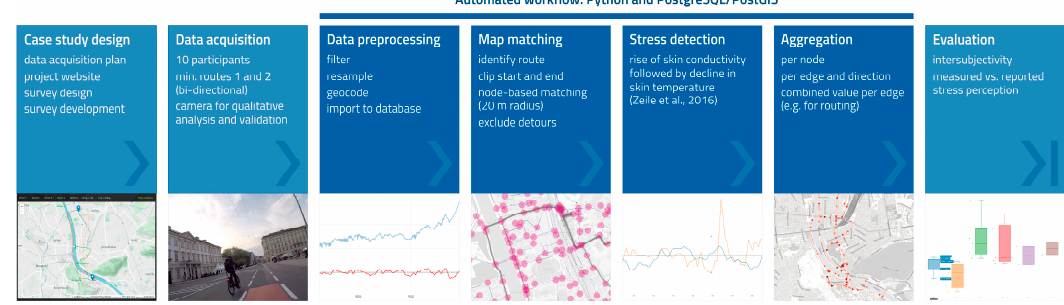
Figure 3. Summary of methods with automated workflow highlighted.